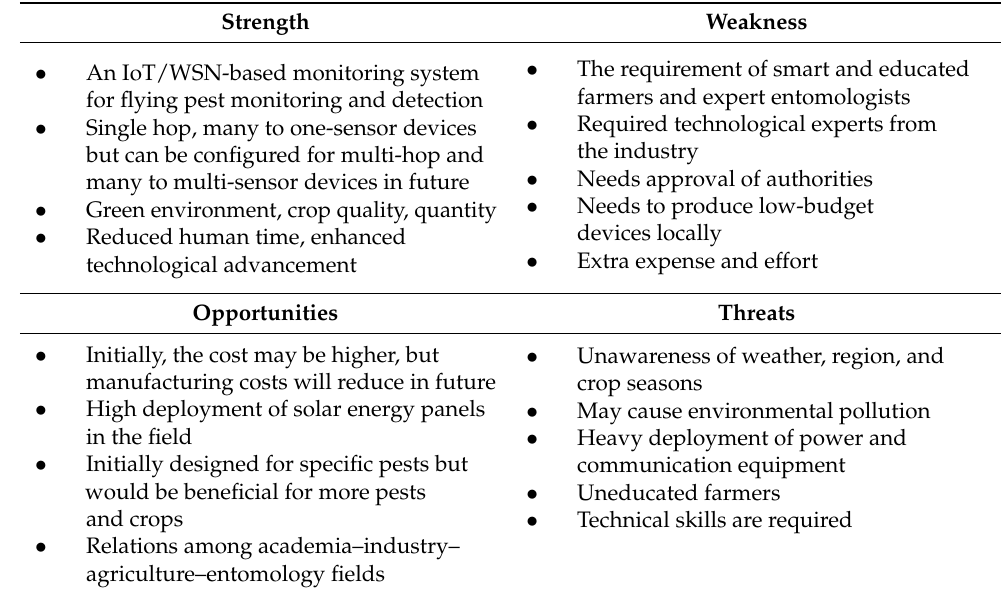
Table 4. SWOT analysis of the proposed